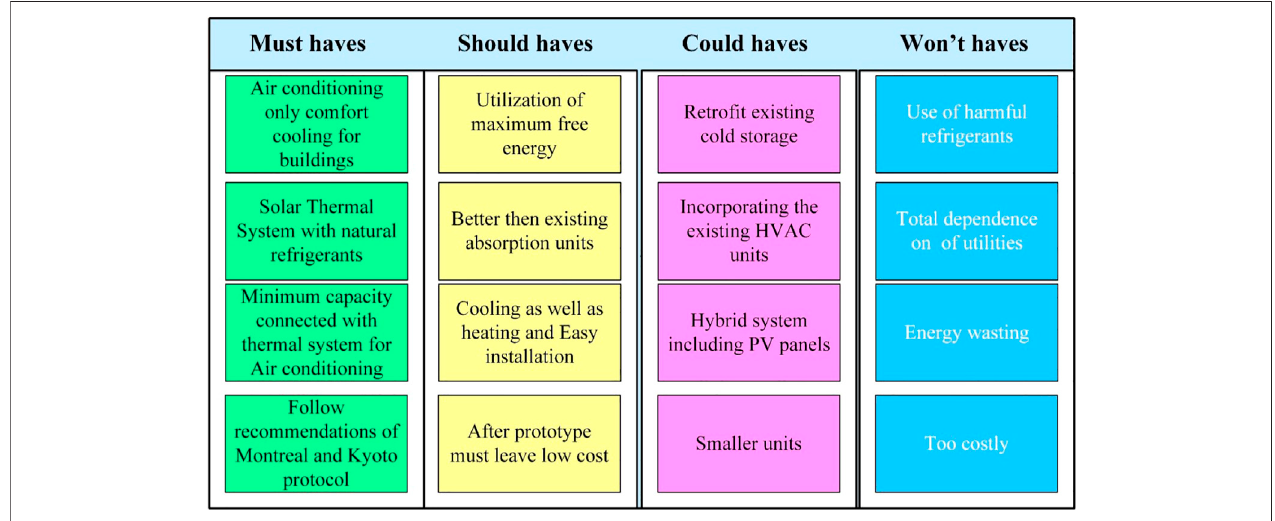
FIGURE 12 | Design criteria canvas, requirement of MVP adapted from Van Der Pijl et al. (2016b).